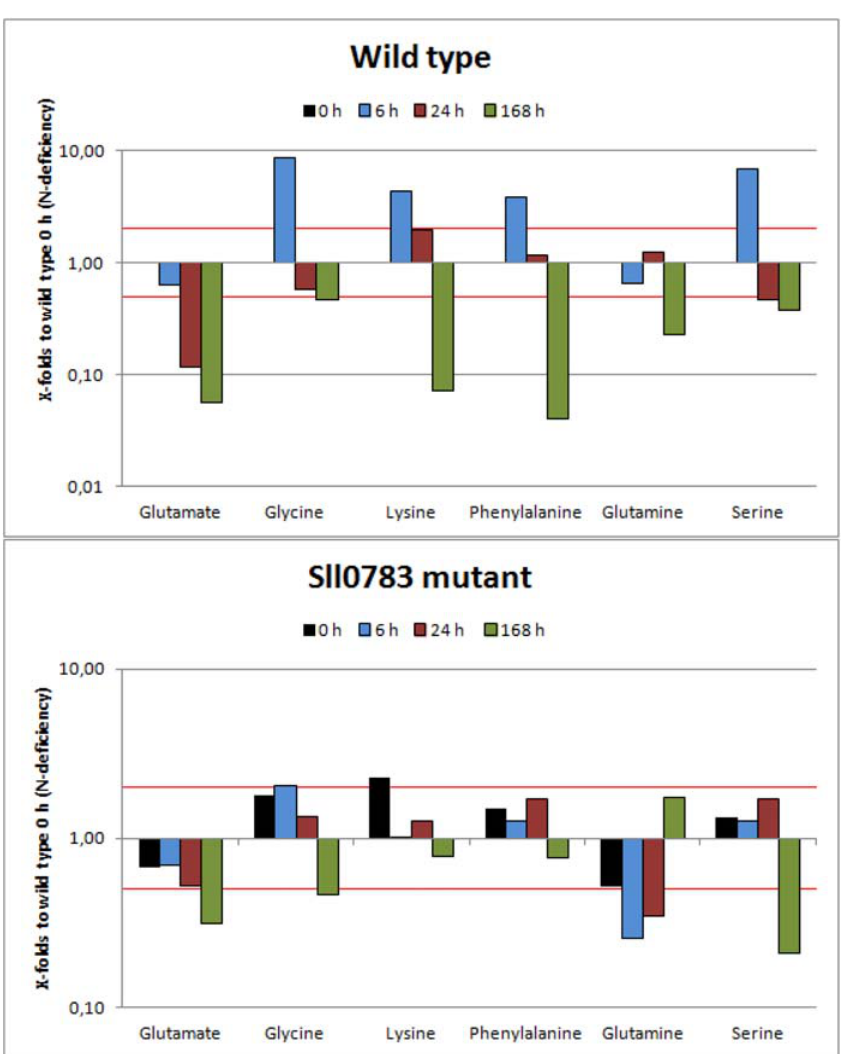
Figure 2. Amino acid levels of the wild type and the sll0783 mutant throughout nitrogen starvation. Black bars represent the metabolites levels prior to nitrogen starvation (0 h), cyan bars represent values obtained 6 h, red bars 24 h and green bars 168 h after nitrogen starvation has been induced. All bars represent x-fold changes in metabolite levels compared to the level in wild type at time point 0 h. The red lines mark the values 2 and 0.5. Values above or below these lines represent statistically significant changes of metabolite levels when compared to wild type at time point 0